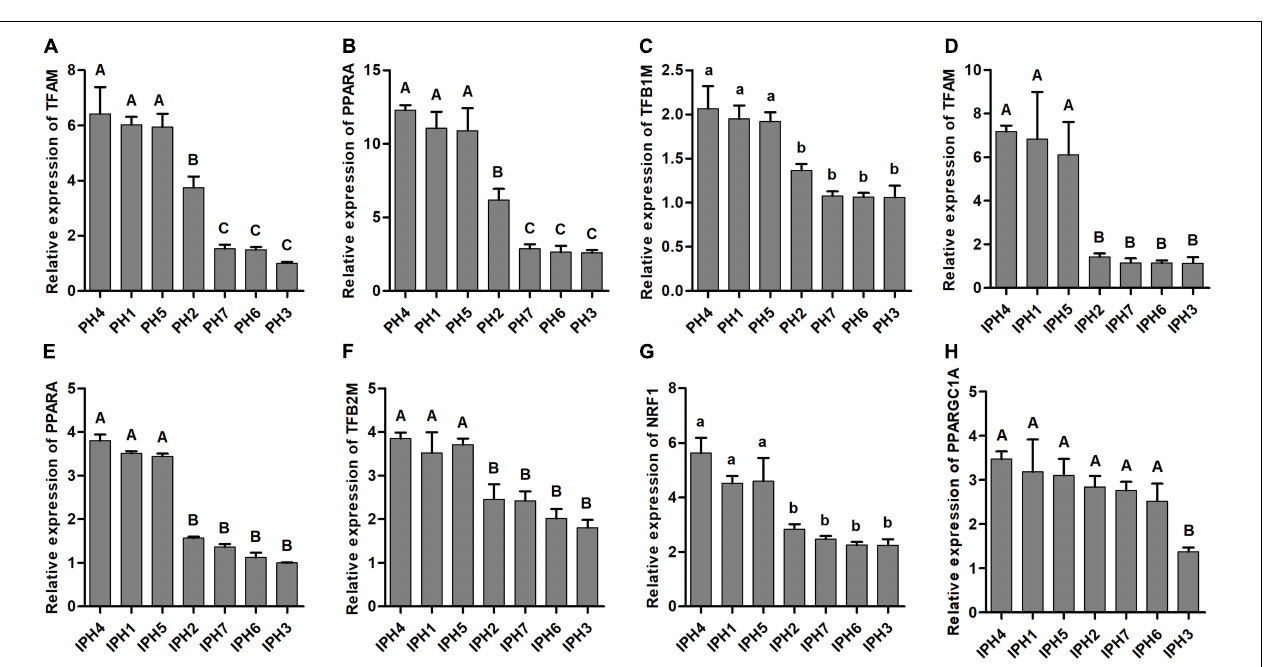
FIGURE 3 | Detections mitochondrial DNA copy number and transcription in fibroblasts and cybrids by RT-qPCR assays. (A) mtDNA copy numbers in fibroblasts. (B) mtDNA copy numbers in cybrids. (C) Transcription levels of mtDNAs in fibroblasts. (D) Transcription levels of mtDNAs in cybrids. Different letters on columns meant extremely significant differences at P < 0.01. PH1-7, fibroblast with mitotype 1–7, respectively, IPH1-7, cybrid with mitotype 1–7, respectively.